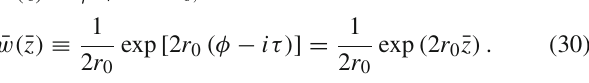
figuration. This bulk AdS 3 geometry characterizes one of